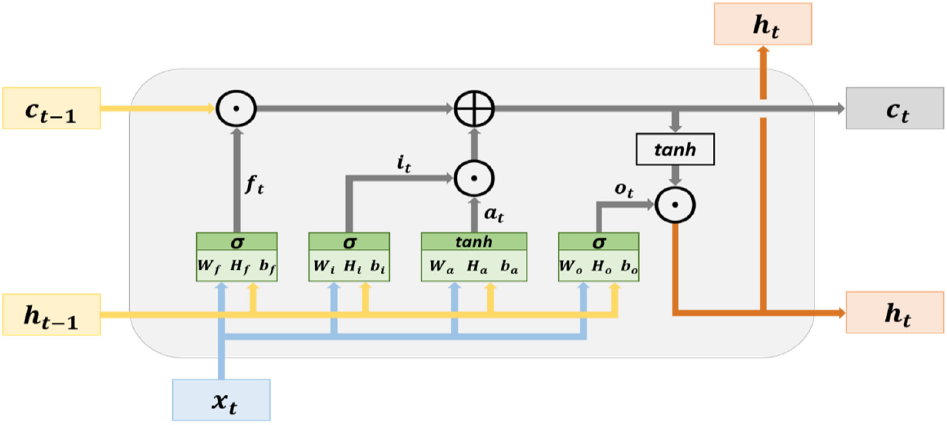
Figure 1. Architecture of LSTM memory